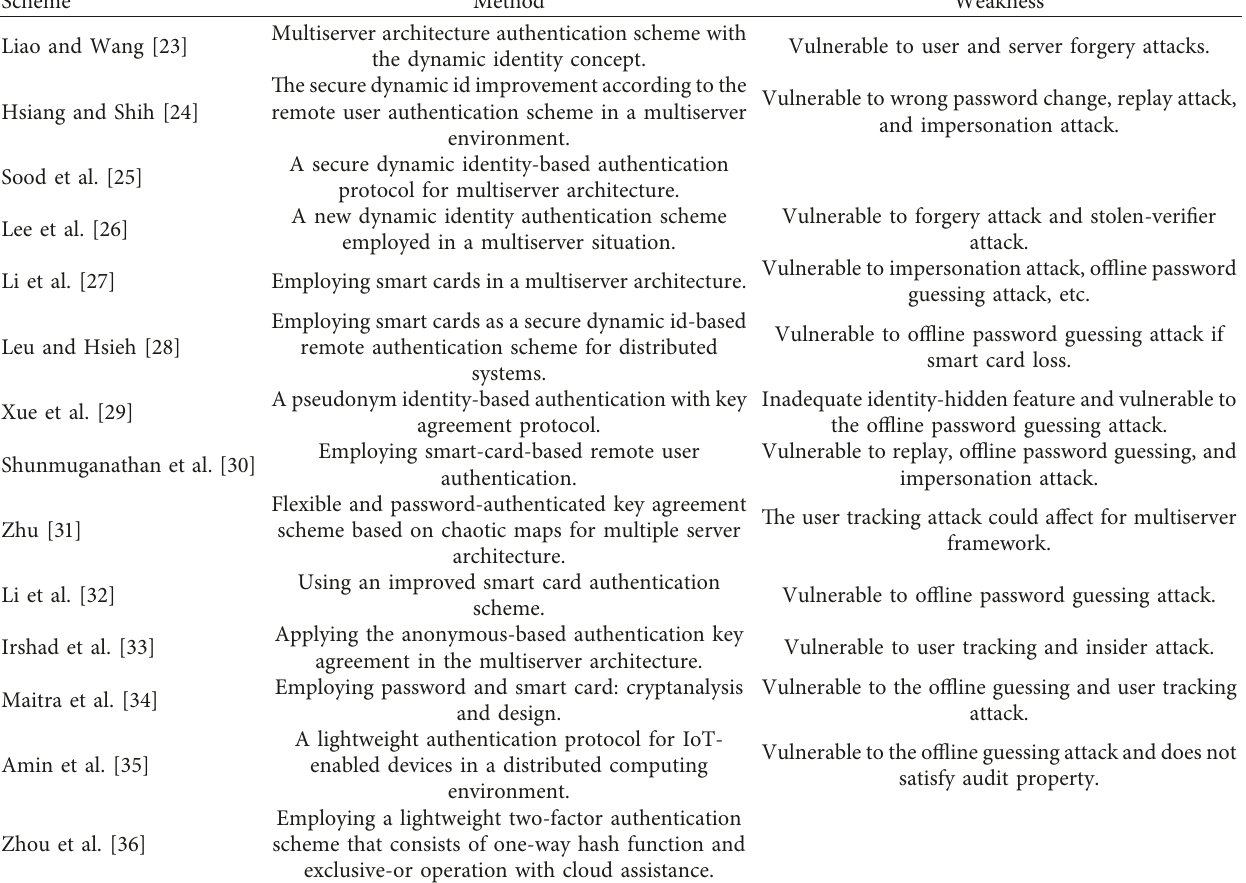
Table 2: IoT-cloud architecture authentication schemes.